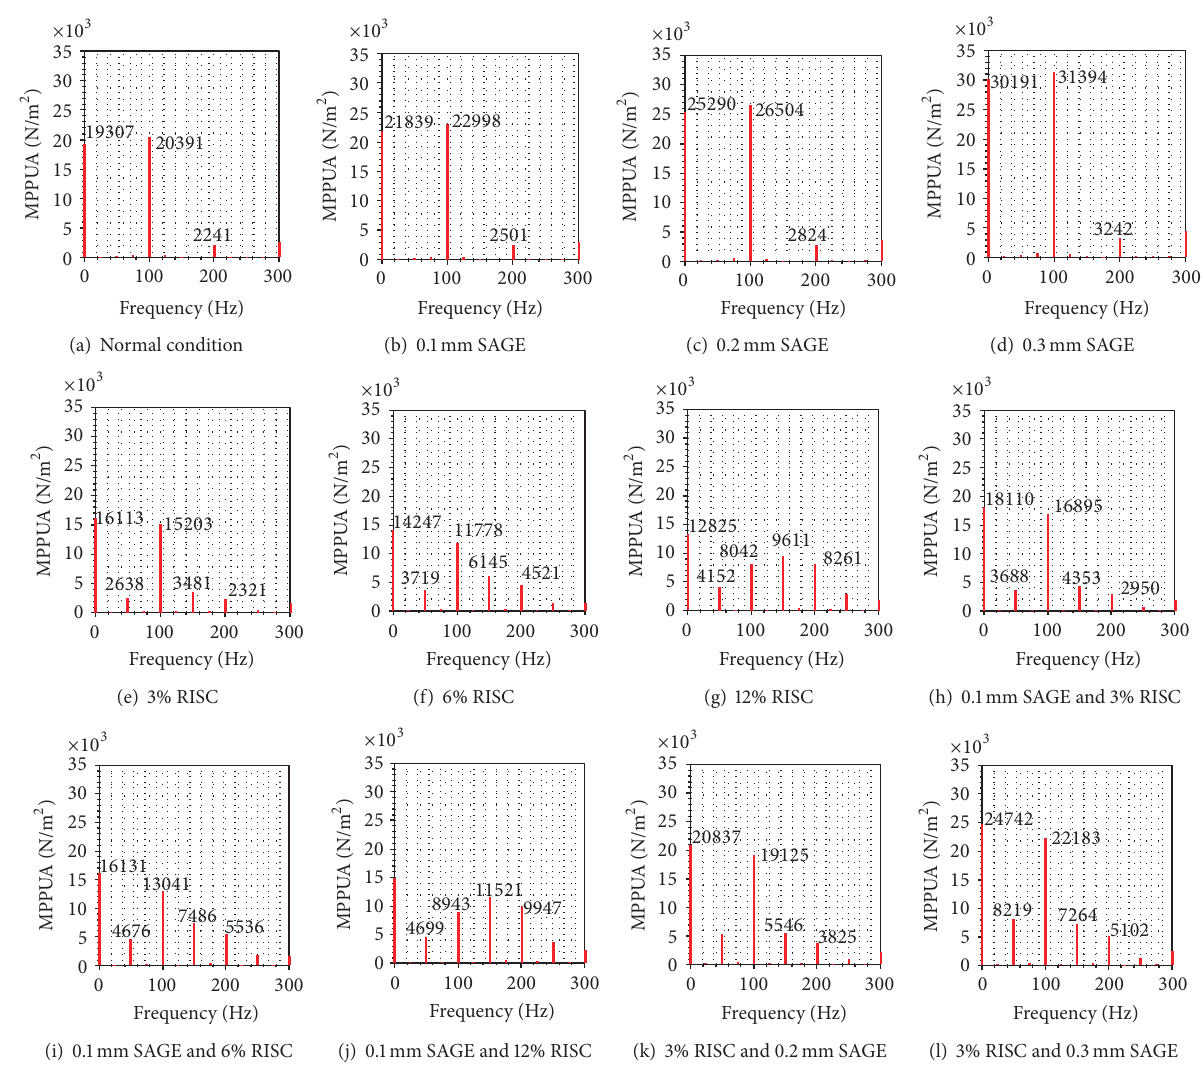
Figure 7: Spectra of MPPUA under different